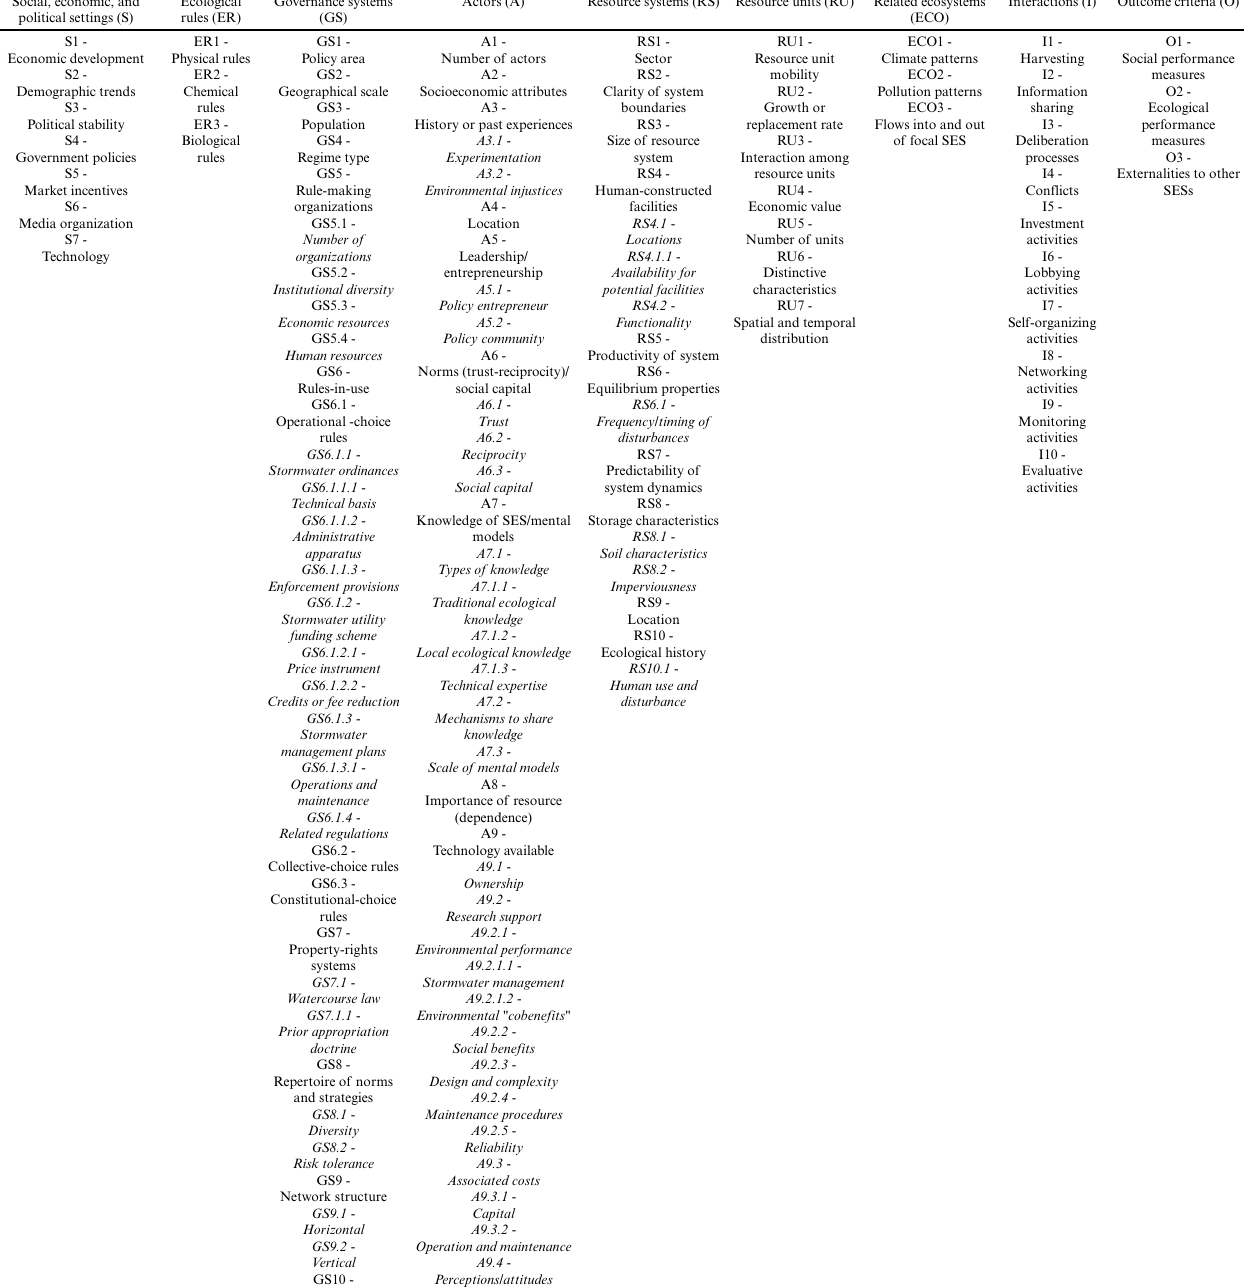
Table 1 . Modified second- through fifth-tier attributes of the urban stormwater social-ecological system (SES) framework. Factors modified from McGinnis and Ostrom (2014), Epstein et al. (2013), and Vogt et al. (2015) that are specific for green infrastructure adoption in urban stormwater social-ecological systems are noted with italic